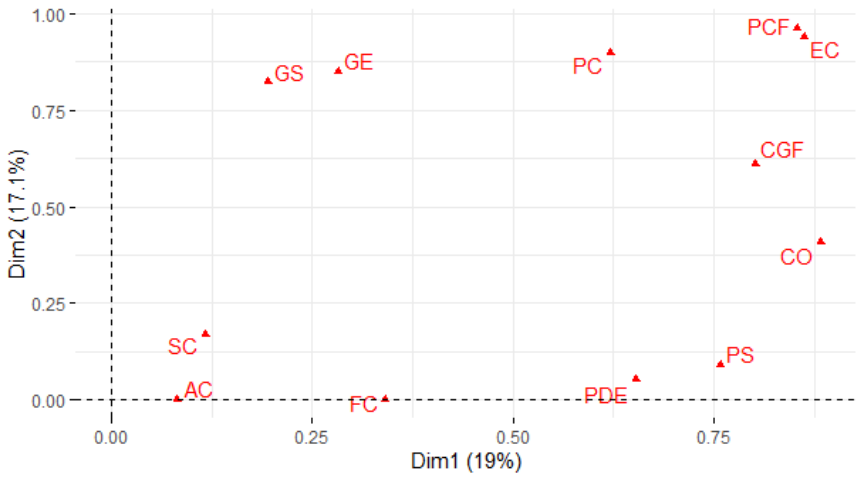
Figure 5. Multiple correspondence analysis showing the contribution of variables, ordering the accessions according to the qualitative variables.